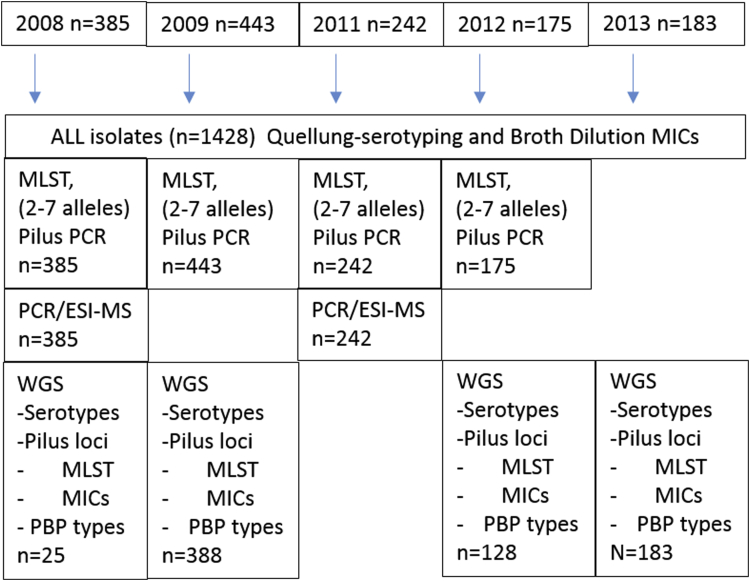
Flow diagram description of the testing performed on 1428 year 2008–2009 and 2011–2013 ABCs isolates.